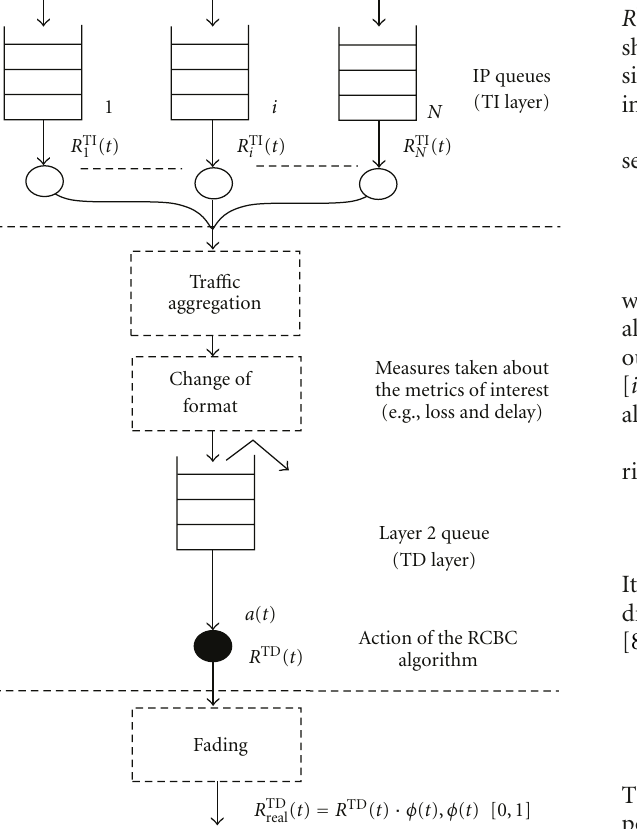
flows a i ( t ) that enter the TI layer. The resulting flow is so complex that can hardly be analytically